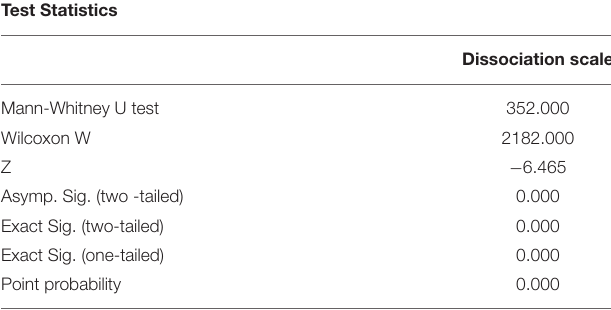
TABLE 3 | Mann-Whitney U test—statistics.